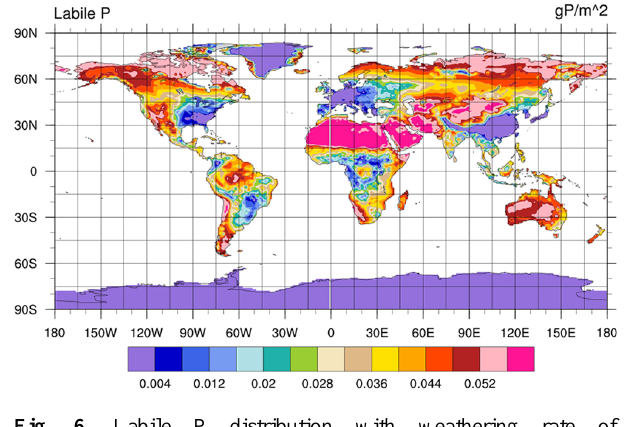
Fig. 6. Labile P distribution with weathering rate of 0.05gPm − 2 yr − 1 .